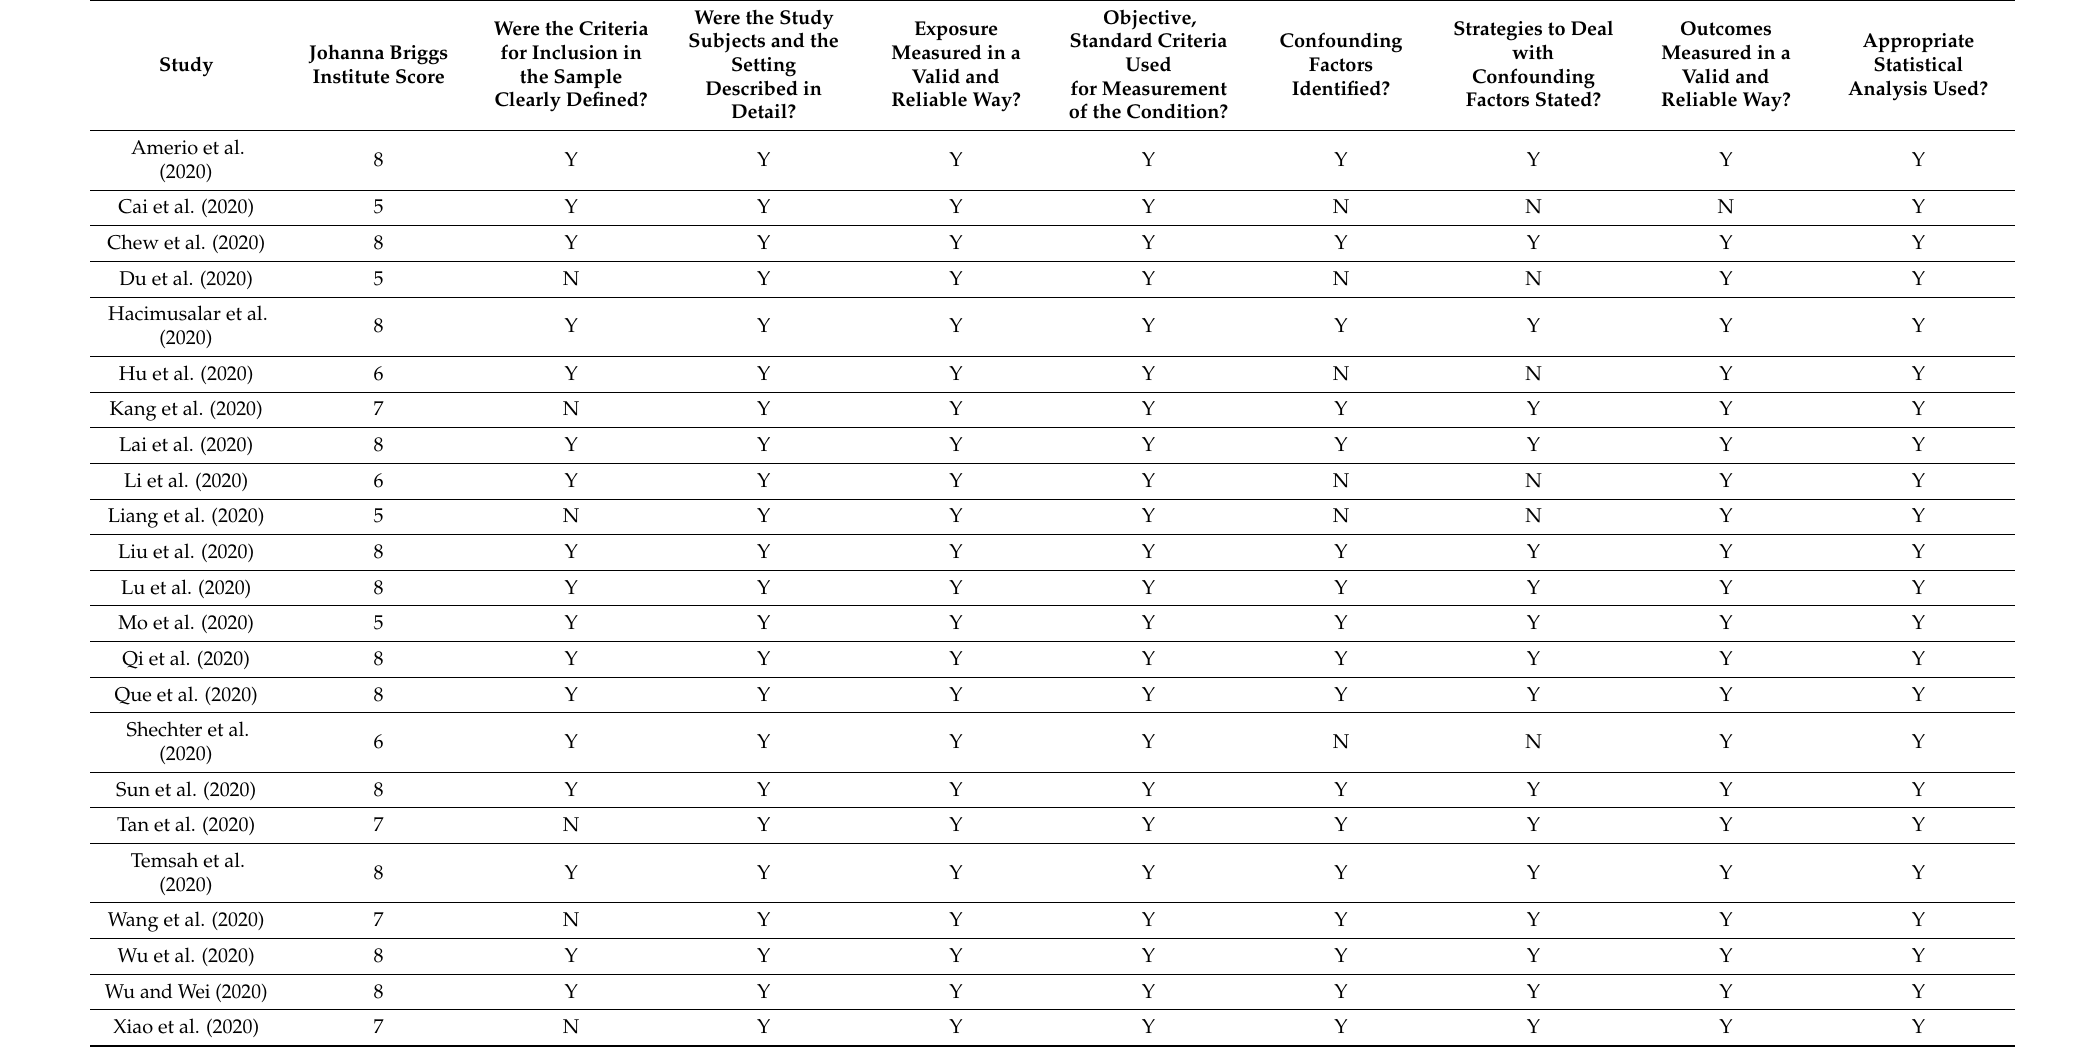
Table 3. Critical appraisal of cross-sectional